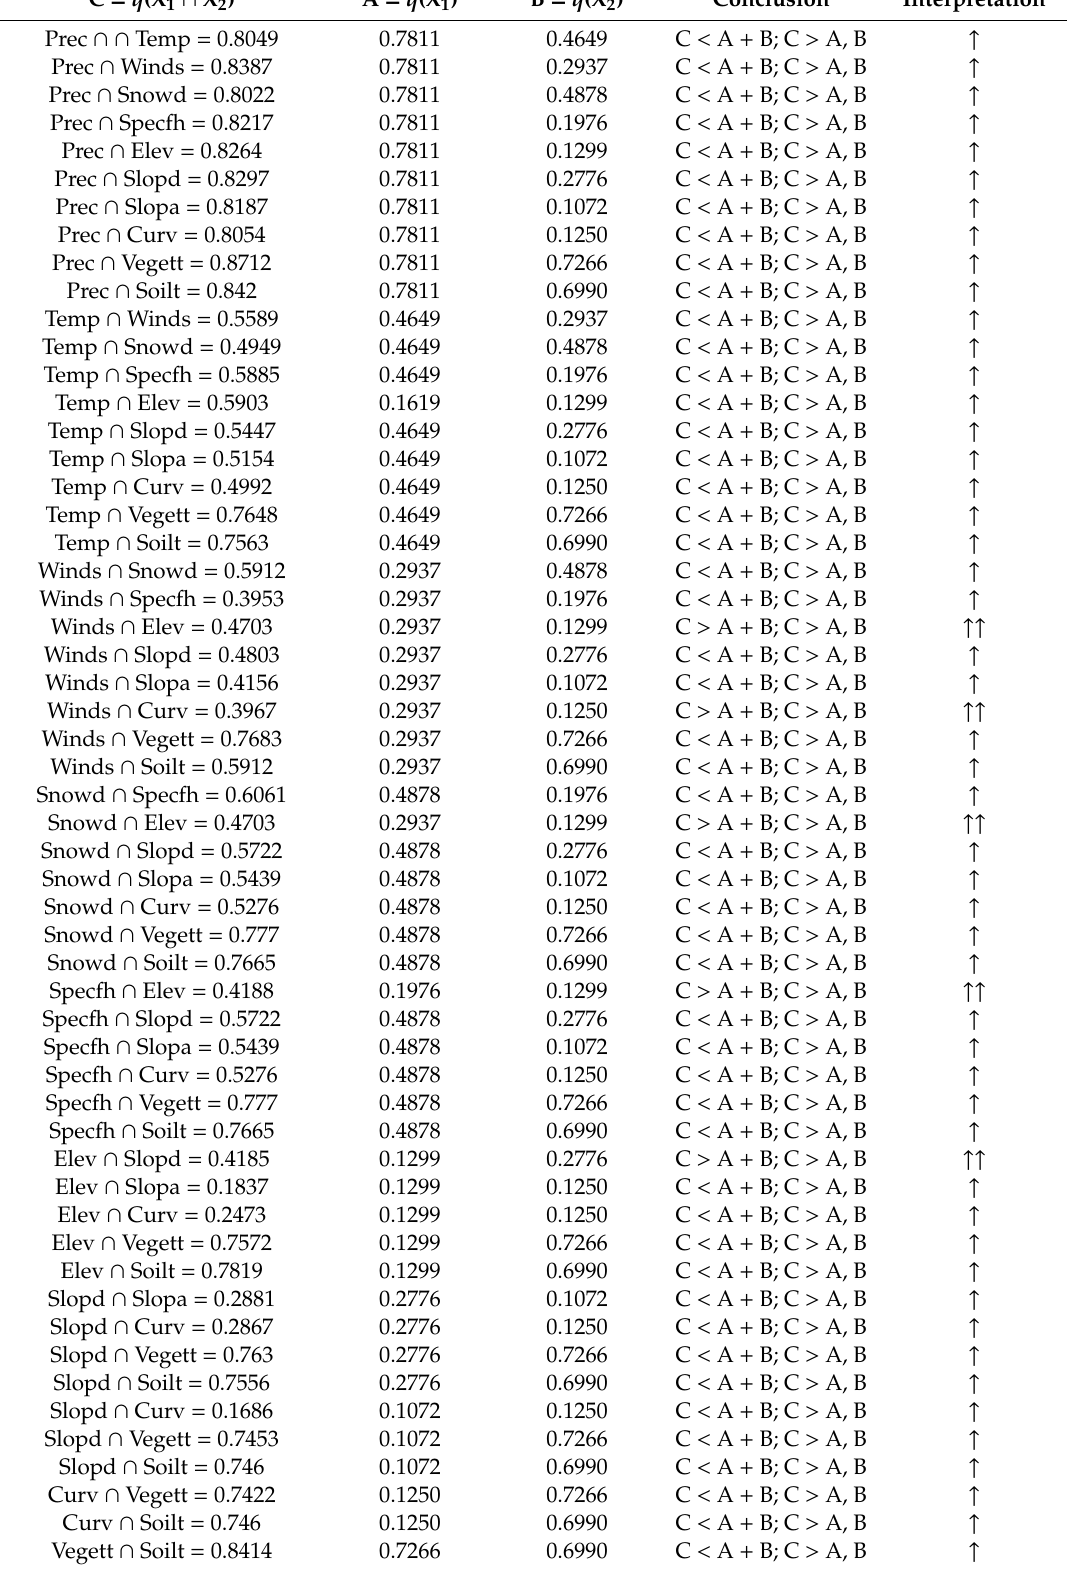
Table 4. Interaction detection between vegetation distribution and environmental